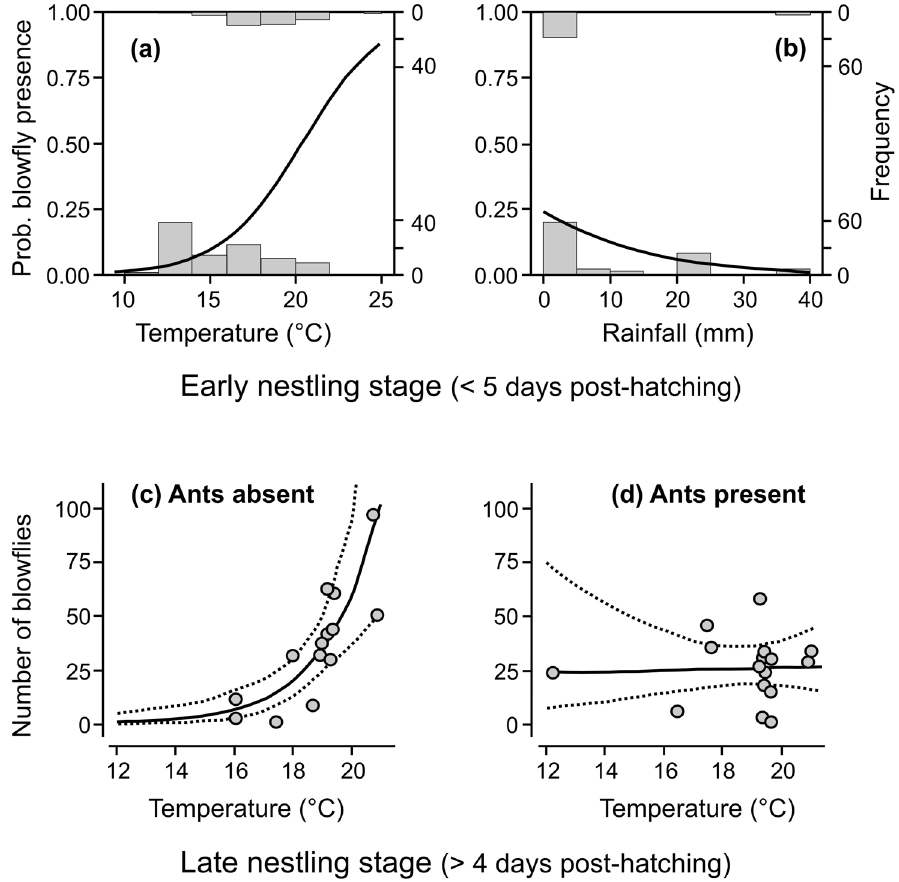
Figure 1. The likelihood of blowfly Protocalliphora azurea presence in relation to weather, ( a ) mean ambient temperature and ( b ) total sum of rainfall, in the early nestling stage of Wood Warblers Phylloscopus sibilatrix ( n = 129 nests). Additionally, changes in blowfly number in parasitised nests with increasing mean ambient temperature in the late nestling stage: ( c ) nests without ants ( n = 14 nests) and ( d ) nests with ants ( n = 16 nests). Solid lines represent trends, and dashed lines are 95% confidence intervals (CIs) of hurdle models with ΔAICc = 0.00 (Table 1; package pscl 92,93 ). Shown are histograms of the number (frequency) of nests containing blowflies (upper) and those without blowflies (bottom) (grey bars in panel a and b